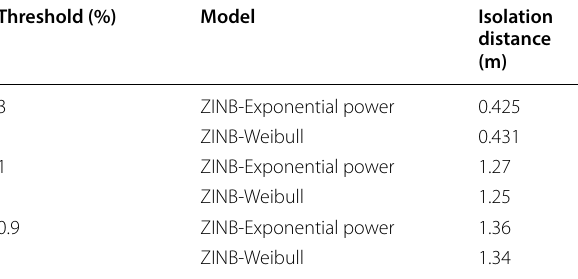
Table 5 Isolation distance (m) evaluated by both zero- inflated negative binomial (ZINB)-exponential power and ZINB-Weibull models under threshold values 3%,